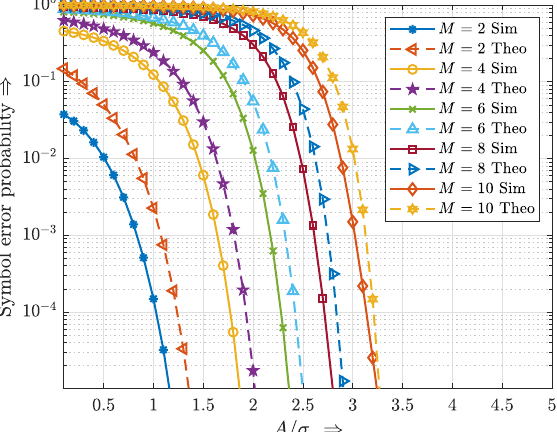
Figure 4. Theoretical versus simulated symbol error probability in a clipped OFDM transmission system, based on the Bussgang theorem. For this graph, the out-of-band distortion is filtered